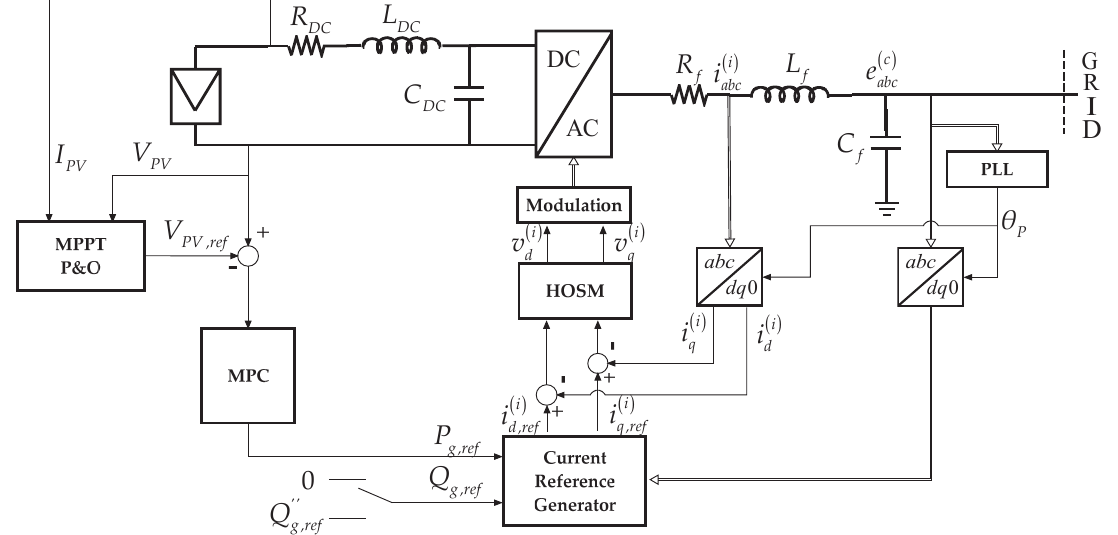
Figure 3. Proposed control system scheme referring to a single line diagram.